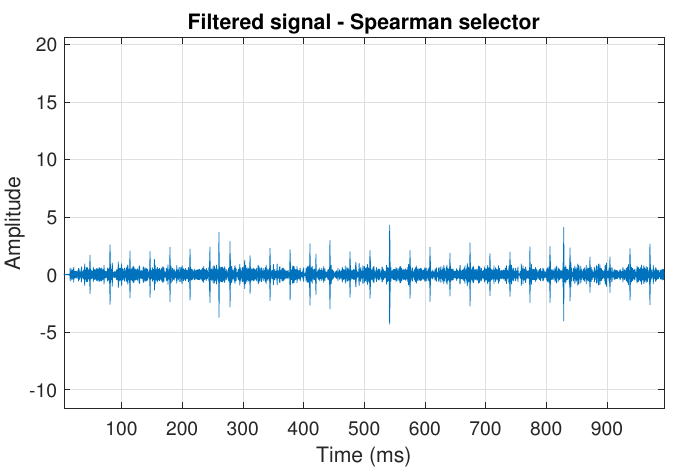
Figure 35. Spectrogram of filtered signal s 4 by CVB selector.